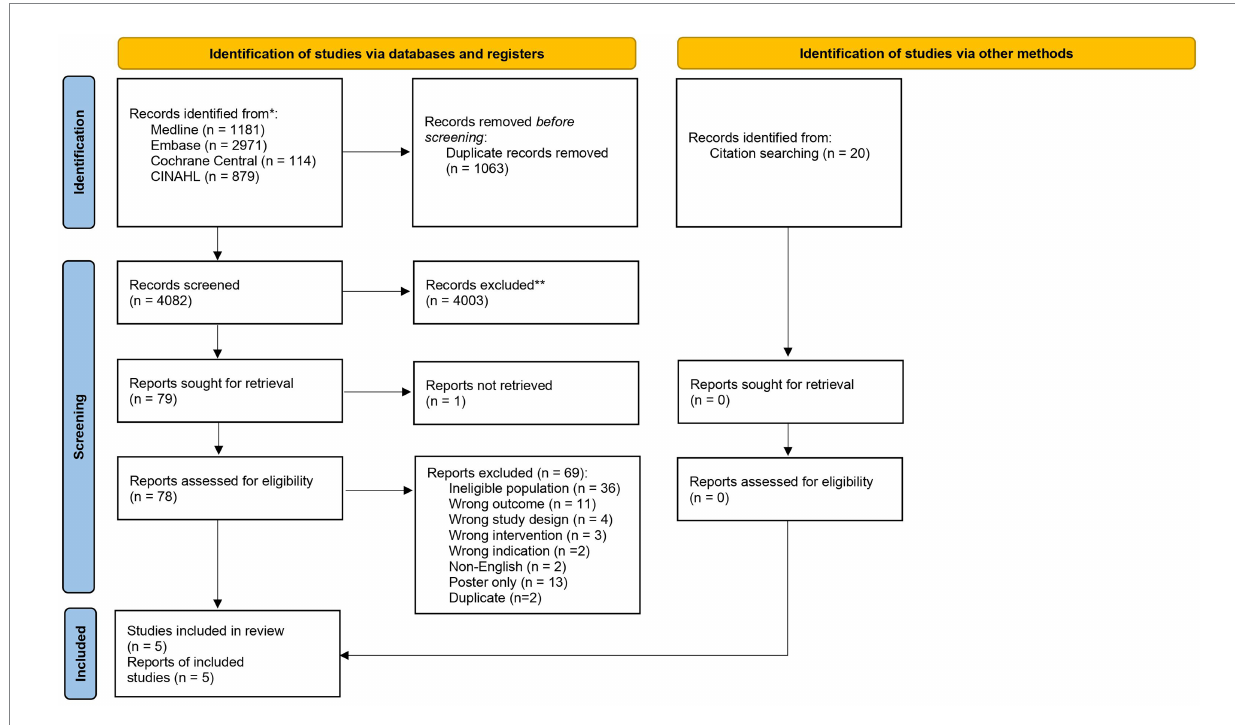
FIGURE 1 PRISMA flow diagram displaying databases searched, number of articles screened, and overall study